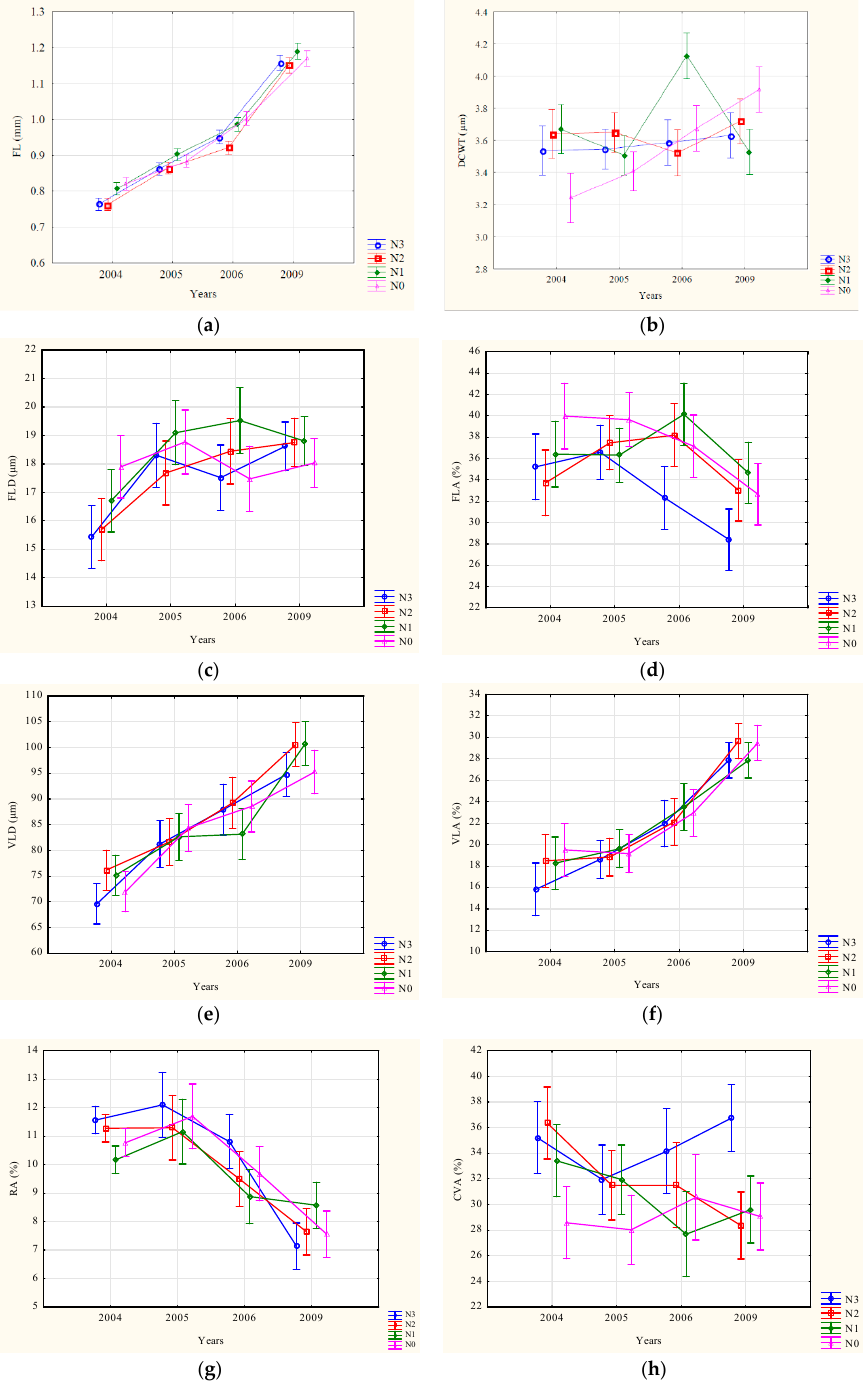
Figure 1. Trends of the anatomical properties of juvenile wood for control and different levels of nitrogen fertilisation by year. ( a ) FL—fibre length; ( b ) DCWT—double cell wall thickness; ( c ) FLD—fibre lumen diameter; ( d ) FLA—fibre lumen area; ( e ) VLD—vessel lumen diameter; ( f ) VLA—vessel lumen area; ( g ) RA—ray area; ( h ) CWA—cell wall area. The vertical bars represent 0.95 confidence intervals.